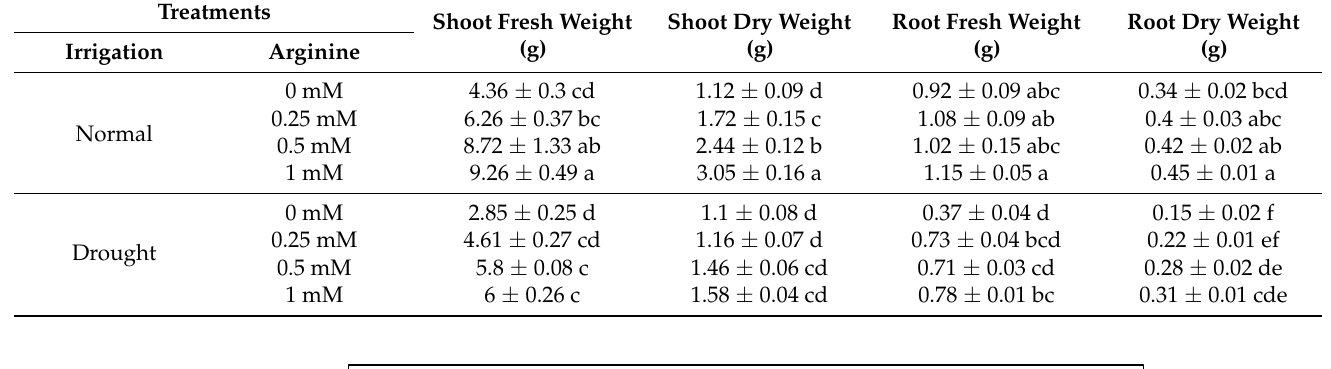
Table 2. Effect of drought, arginine application, and their interactions on shoot fresh weight (g), shoot dry weight (g), root fresh weight (g), and root dry weight (g) of wheat plants. Values represent mean ± standard error. Means that do not share the same letter are significantly different.